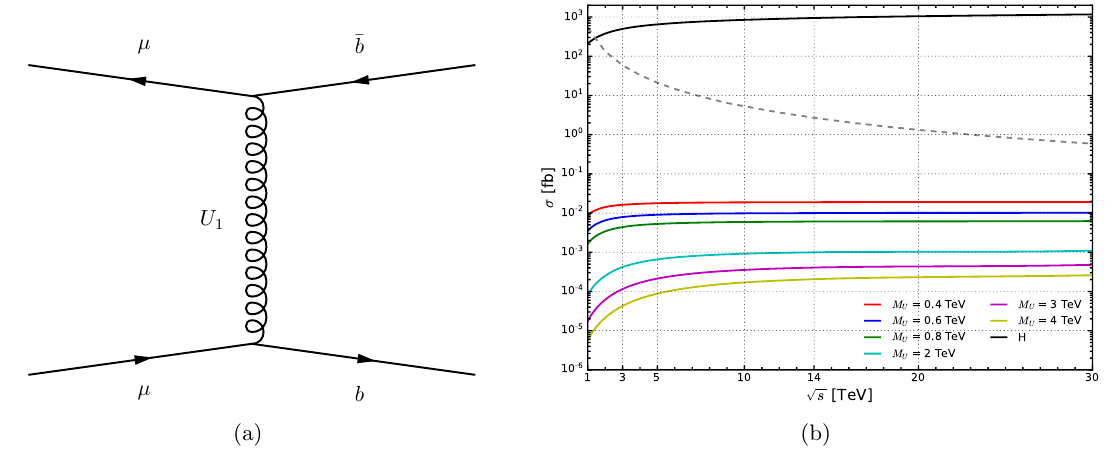
Figure 13 . (a) Diagrammatic representation of bb production in (cid:22) + (cid:22) (cid:0) collisions via the t -channel exchange of the vector leptoquark U (cid:22) . (b) The associated cross section [fb] as a function of collider 1 p energy s [TeV] for representative M U . Also shown is SM (cid:22) + (cid:22) (cid:0) ! bb production (dashed curve). . 1 TeV, we see that cross sections representative stop masses. For lighter stops with m ~ t p p span (cid:27) (cid:24) 0 : 01 (cid:0) 1 fb at s (cid:24) 2 TeV and reach (cid:27) (cid:24) 50 (cid:0) 75 fb at s (cid:24) 30 TeV. For heavier p stops with m ~ = 2 (cid:0) 4 TeV, production rates reach (cid:27) (cid:24) 5 (cid:0) 20 fb at s (cid:24) 30 TeV. t In (cid:12)gure 12(d), we show the same information but for ~ (cid:31) 0 ~ (cid:31) 0 . Overall, the picture is . 1 TeV, pair production rates through weak bleaker. For lighter neutralinos with m ~ (cid:31) 0 p boson fusion remain below (cid:27) (cid:24) 0 : 01 fb for collider energies below s (cid:24) 7 (cid:0) 10 TeV. They p reach just below (cid:27) (cid:24) 0 : 2 fb at s (cid:24) 30 TeV. For heavier neutralinos with m = 2 (cid:0) 4 TeV, ~ (cid:31) 0 p we see that cross sections remain below (cid:27) (cid:24) 0 : 1 fb for s . 30 TeV. In (cid:12)gure 12(f), we again show the same information but for ~ (cid:31) + ~ (cid:31) (cid:0) . We (cid:12)nd that the . 1 TeV, outlook is somewhere between the previous cases. For lighter charginos with m ~ (cid:31) (cid:6) p pair production rates quickly reach about (cid:27) (cid:24) 0 : 01 fb for s (cid:24) 2 (cid:0) 4 TeV and about p . 2 (cid:0) 4 TeV, rates reach (cid:27) (cid:24) 75 fb at s (cid:24) 30 TeV. For heavier charginos with m ~ (cid:31) (cid:6) p (cid:27) (cid:24) 0 : 01 (cid:0) 1 fb when s (cid:24) 7 (cid:0) 12 TeV, and span roughly (cid:27) (cid:24) 20 (cid:0) 40 fb for the highest